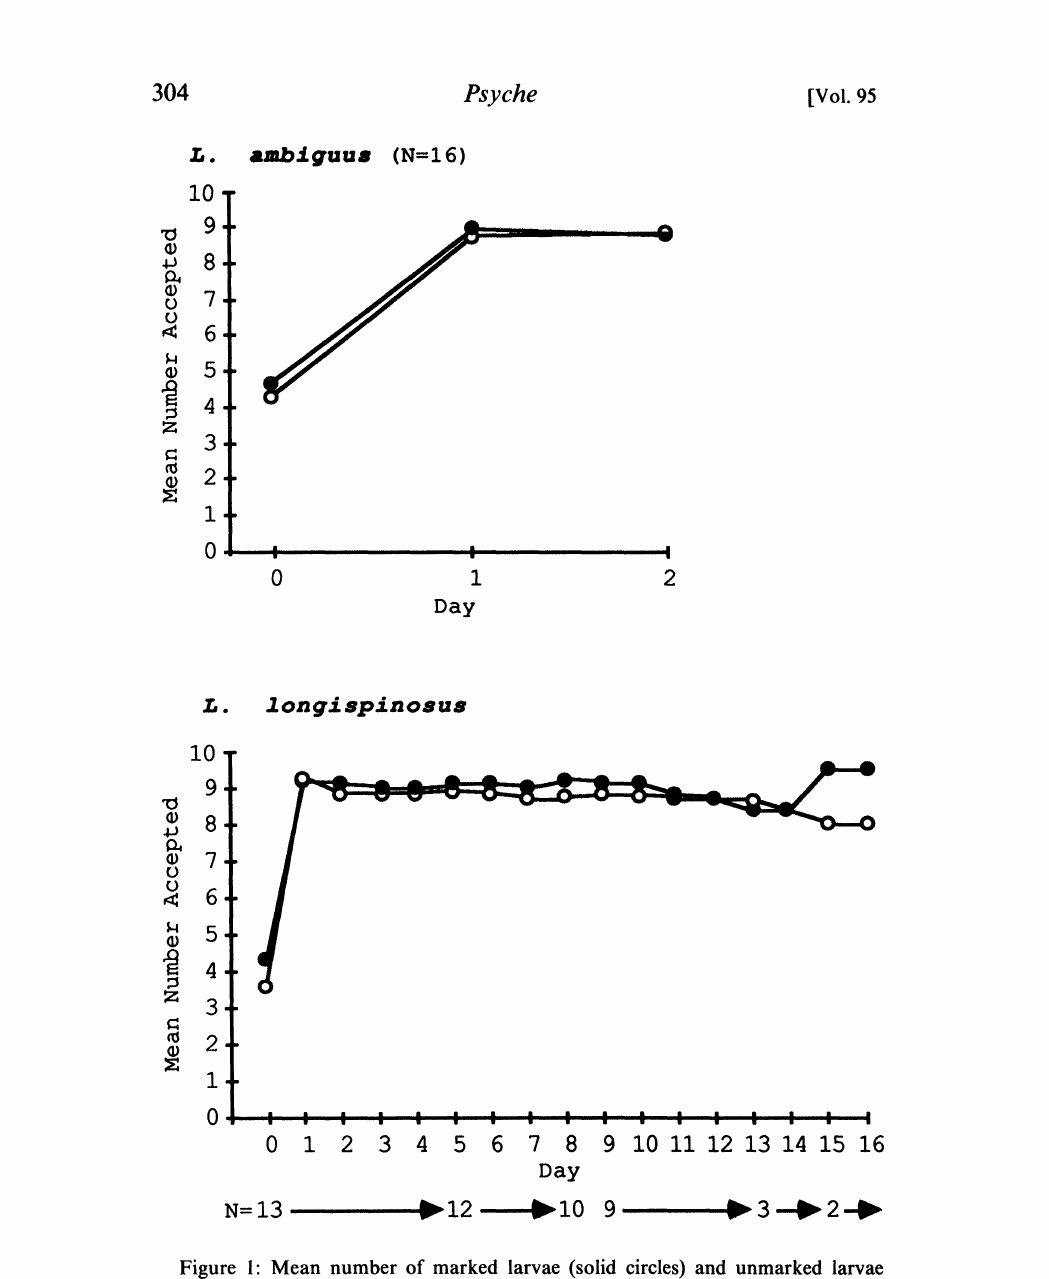
Figure 1: Mean number of marked larvae (solid circles) and unmarked larvae (open circles) accepted by Leptothorax worker groups over time. [Note Day 0 number accepted upon termination of paired